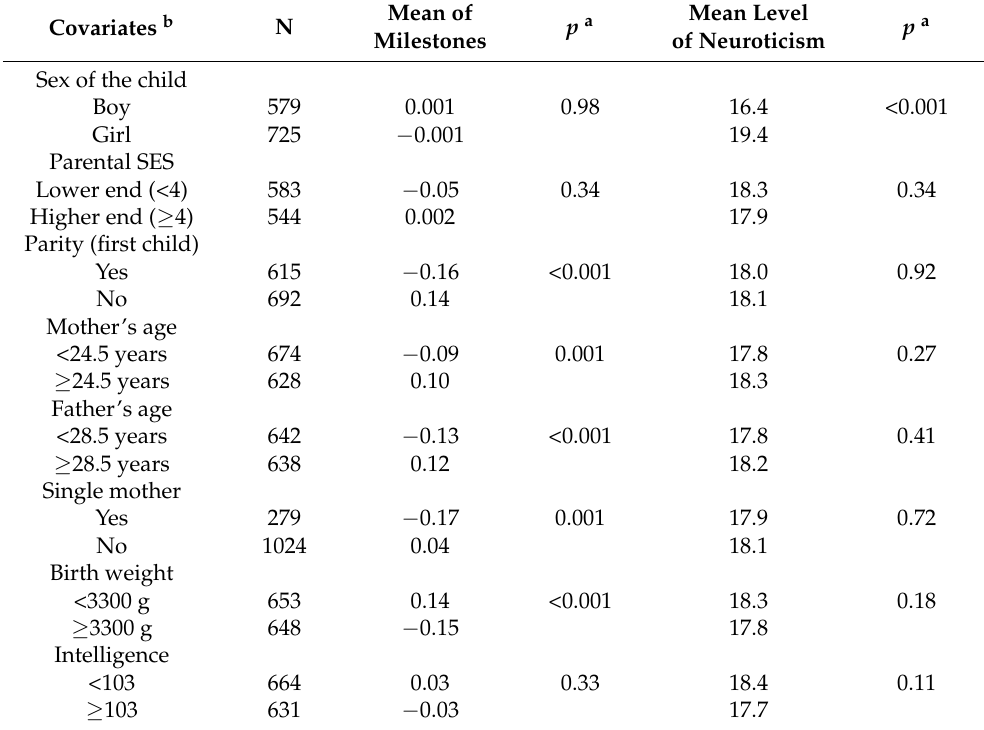
Table 2. Associations of covariates with the overall mean of milestones and neuroticism. Covariates b N